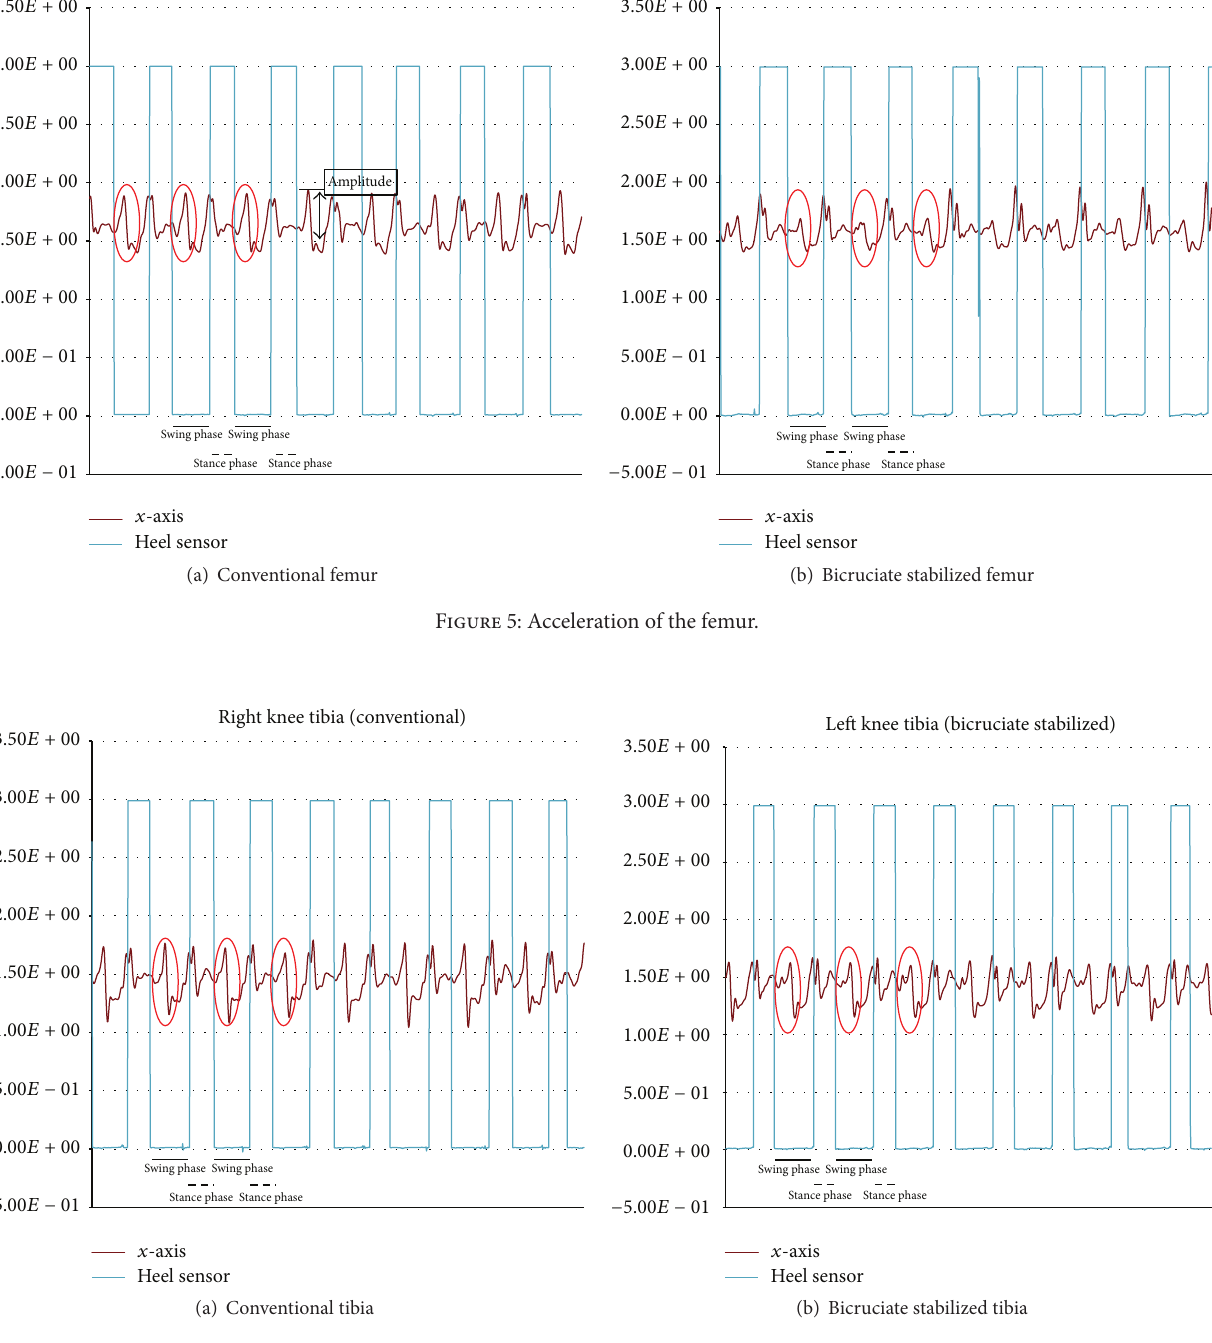
Figure 6: Acceleration of the